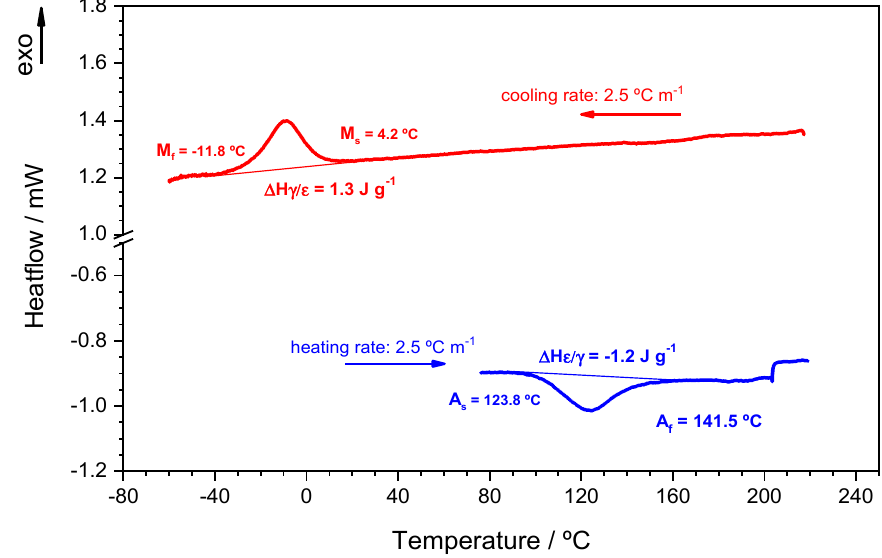
Figure 7. DSC curve corresponding to the heating and cooling cycles of the SMS alloy.